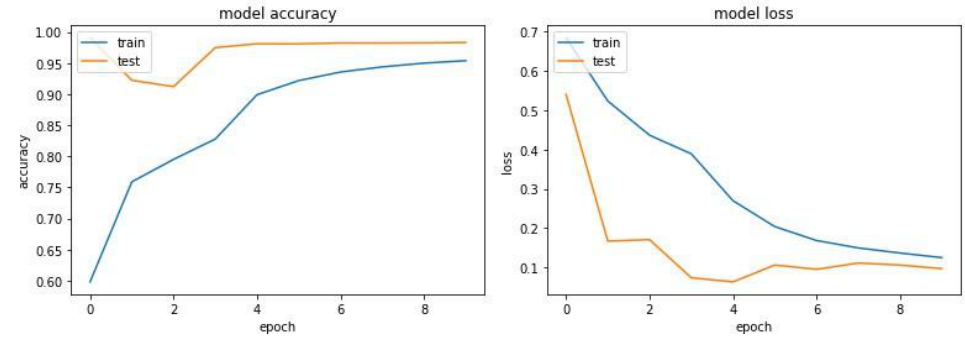
Fig. 9. Accuracy vs Epochs and Loss vs Epochs for training and testing of type